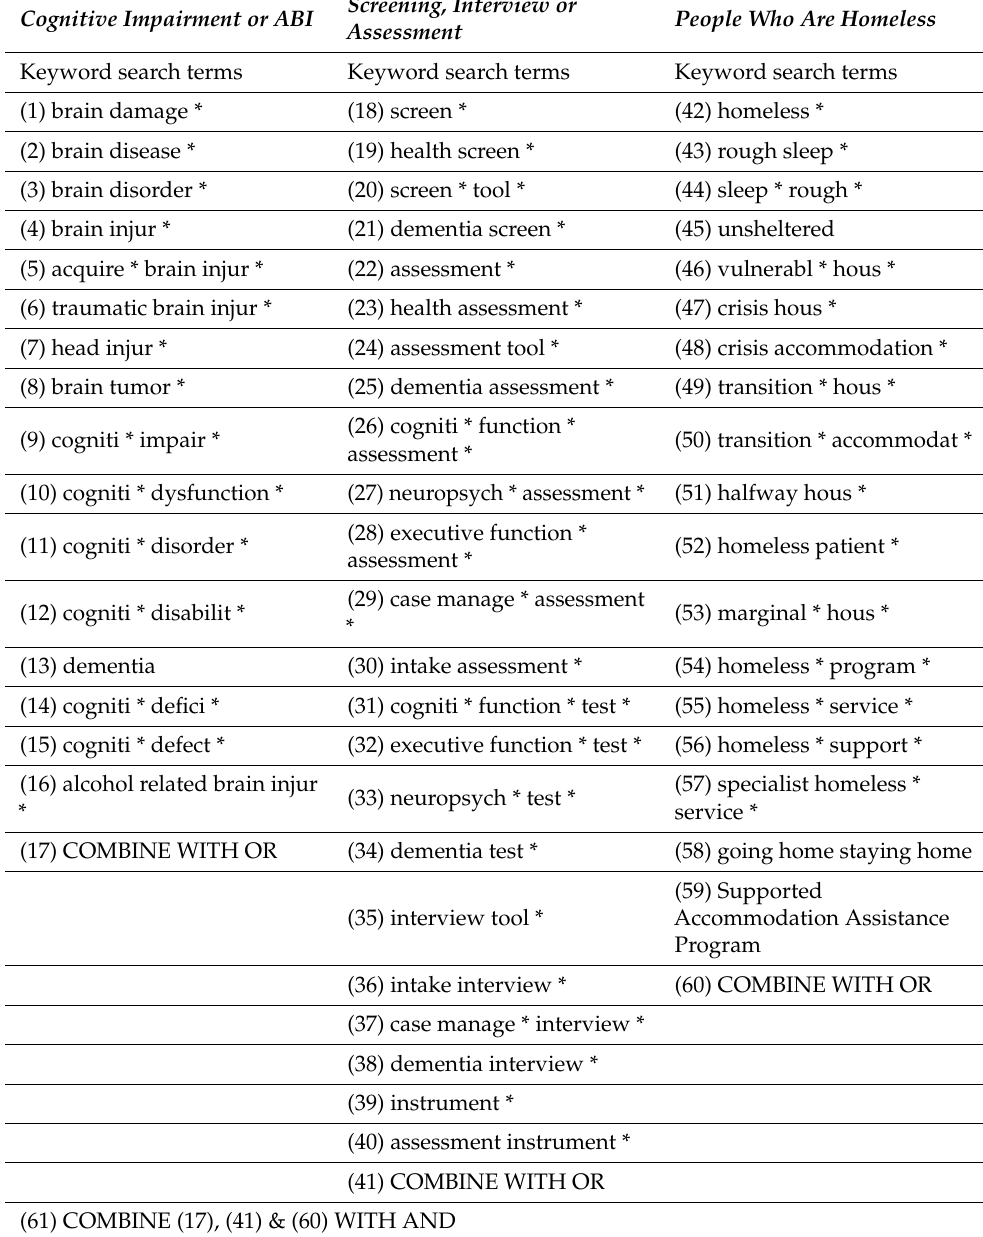
Table A1. Search